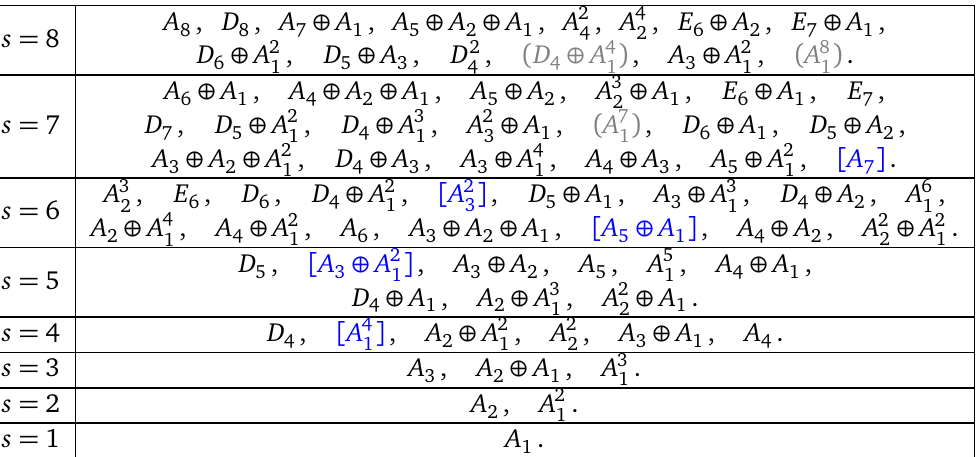
Table 14: Root lattices of rank s that embed into E inequivalent embeddings are shown in [ blue ] , while those that cannot be associated with rational elliptic surfaces are in